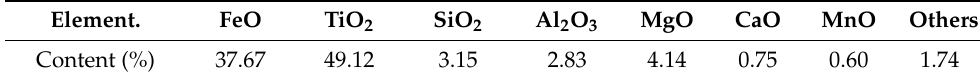
Table 1. The chemical composition of the ilmenite sample.